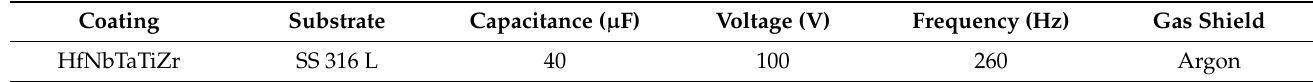
Table 1. ESD parameters for HfNbTaTiZr HEA coatings on stainless steel substrates.